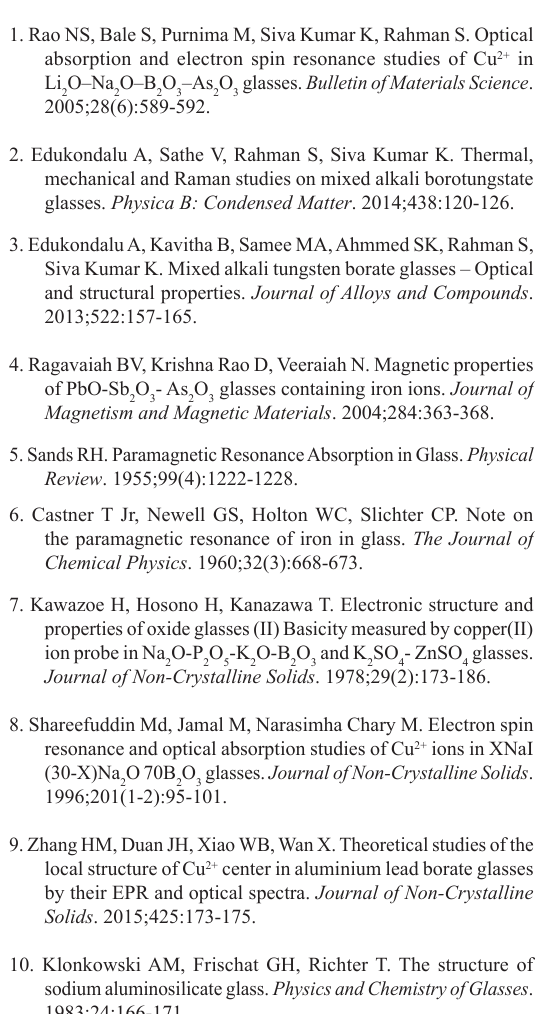
Figure 5: Optical band gap energy (for all transitions) as a function of composition (mol%) in present